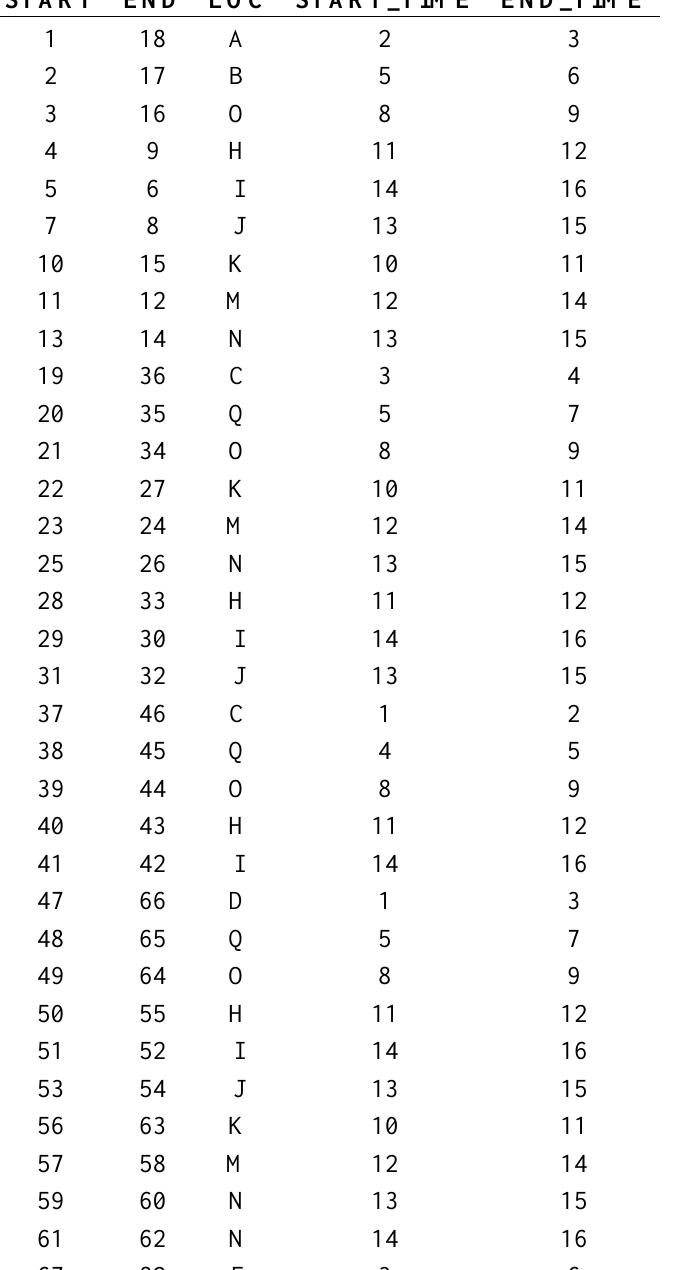
Table 4. Status of tables after storing trace records in Table 1. ( a ) TIME_TABLE